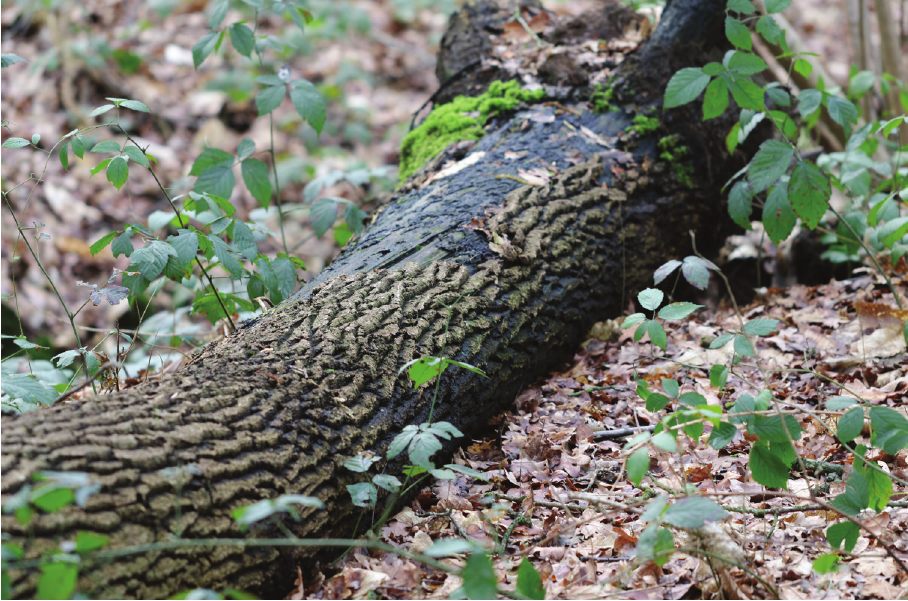
Figures 5. Example in Belgium of trees used by several ichneumonid wasps to hibernate beneath the bark; Quercus robur L., Zillebeke (Hogebos), 14 February 2020 and Pinus sylvestris L., Zillebeke (Pap- enelst), 23 December 2019. Fons